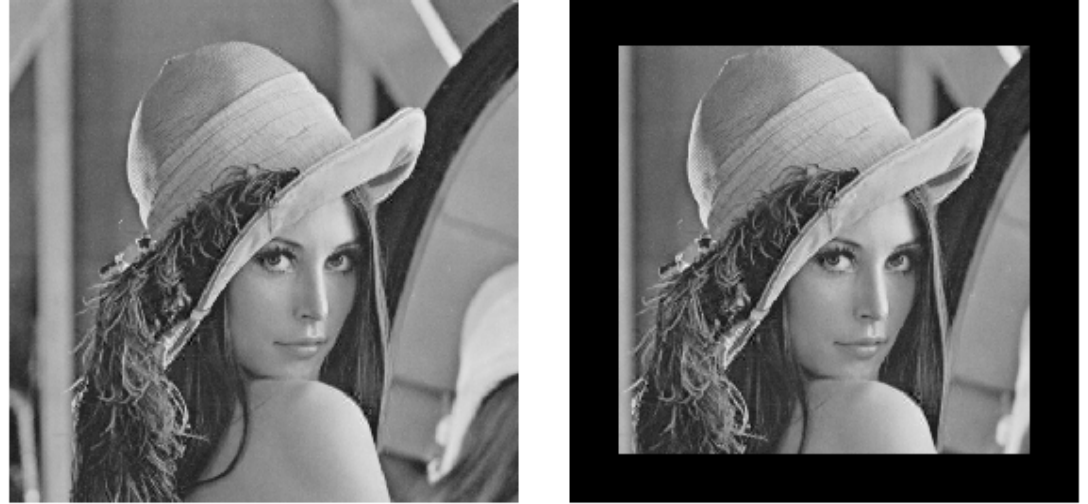
Figure 4. The cropping attack performed on the 512×512 “Lena” image: the watermarked image (left) and the same image with cropped border by 20%